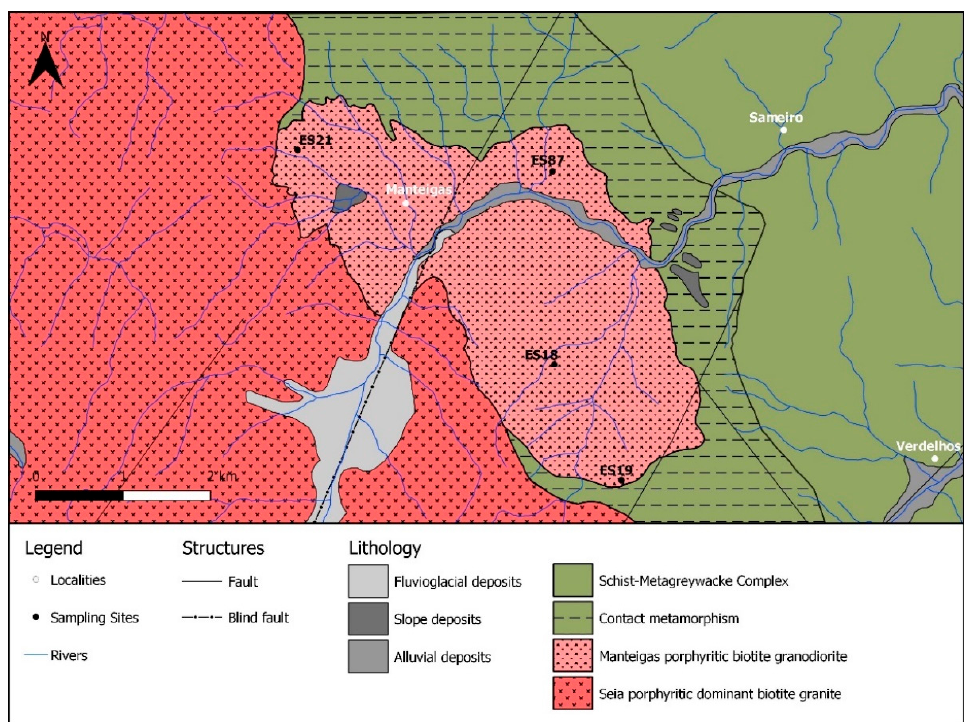
Figure 2. Geological map of Manteigas granodiorite outcrop, with the location of the sampling sites (ES18, ES19, ES21, and ES87).